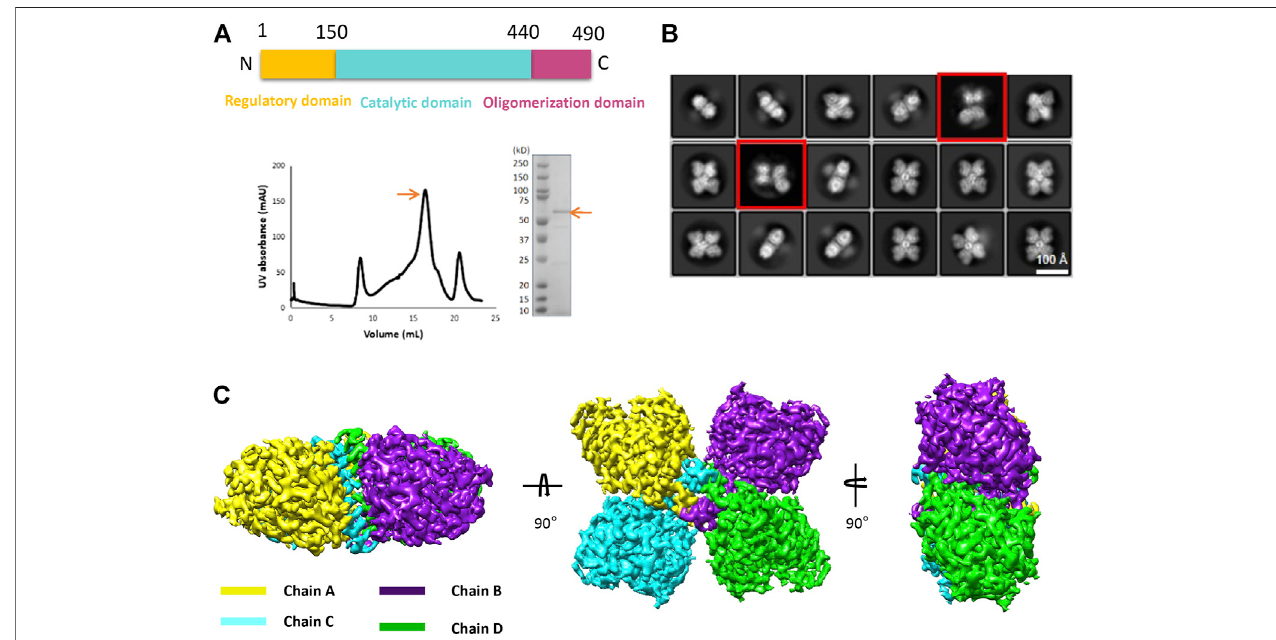
FIGURE 1 | Puri fi cation and structure determination of human tryptophan hydroxylase 2 (TPH2). (A) domain organization, size exclusion chromatography pro fi le, and SDS-PAGE analysis of TPH2 in peak fraction. The target items are indicated with arrows. (B) 2D class average of cryo-EM micrographs of TPH2. The red box indicates the TPH2 asymmetric tetramer in a dynamic state. (C) cryo-EM 3D map of TPH2 tetramer in different views and colored by chain.